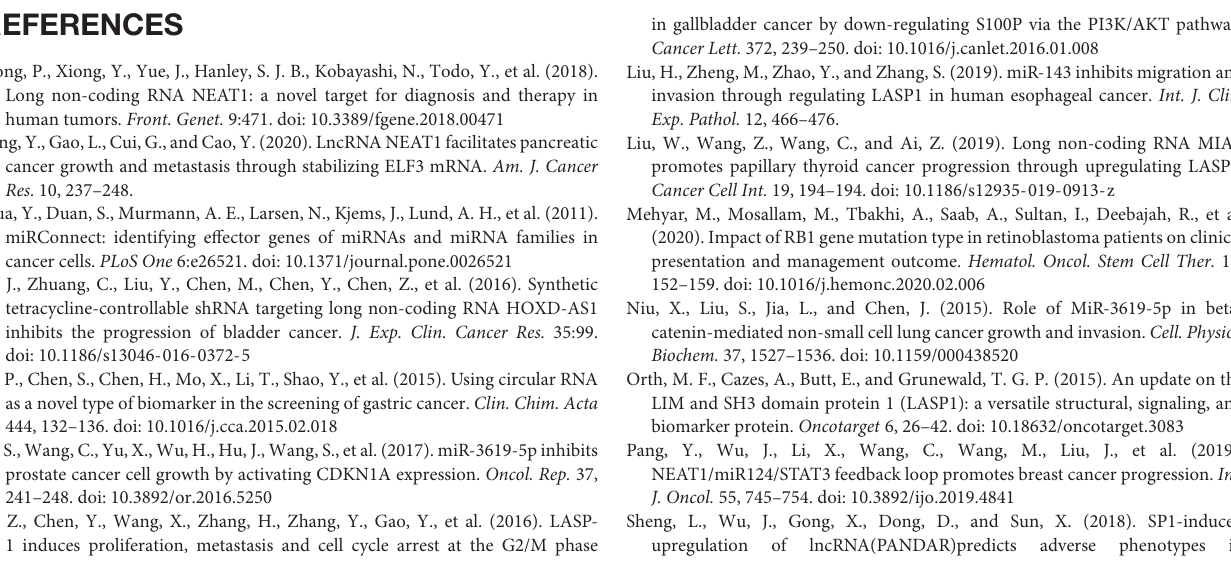
Supplementary Figure 2 | NEAT1 silencing increased the enrichment of LASP1 by miR-3619-5p in Y-79 and SO-RB50 cells. (A) RNA pull-down assay was carried out to detect the amount of LASP1 enriched by miR-3619-5p in Y-79 and SO-RB50 cells. Supplementary Figure 3 | The diagram of mechanism of NEAT1 in regulating RB process. Supplementary Table 1 | Correlation between NEAT1 expression and clinical clinicopathological parameters of